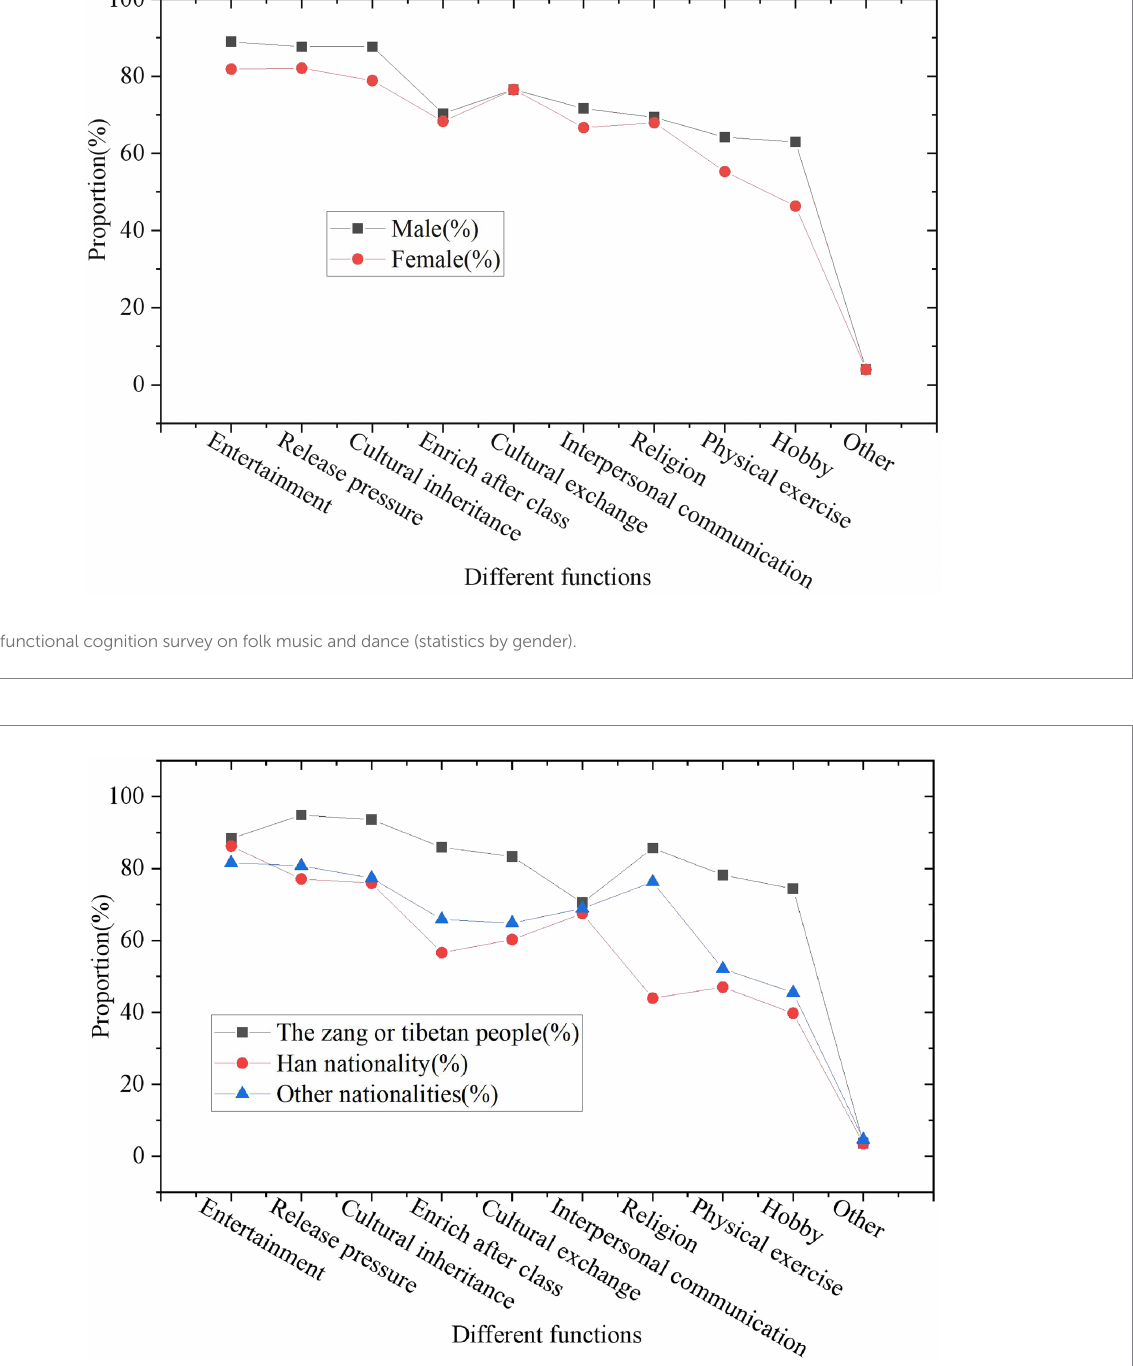
FIGURE 8 Student’s functional cognition survey on folk music and dance (statistics by